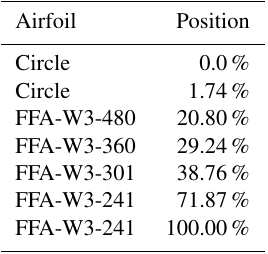
Table 7. Spanwise positioning of the airfoils for the 10MW wind